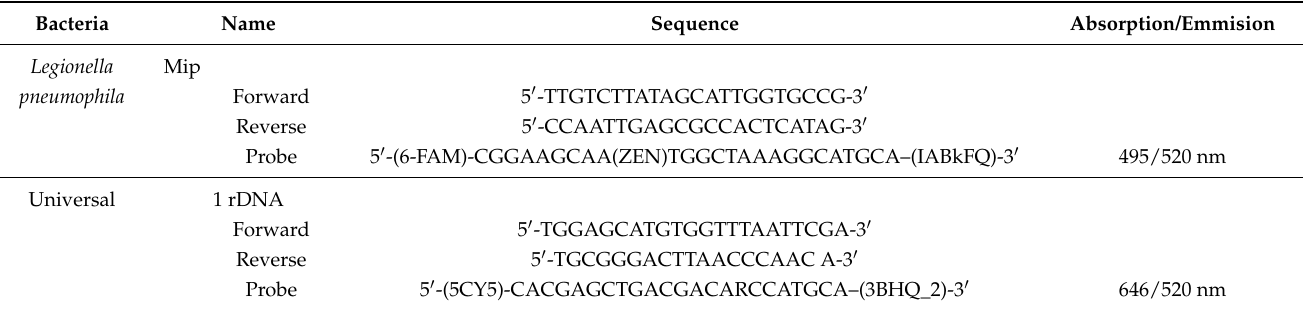
Table 1. Taqman PCR primers and probes.